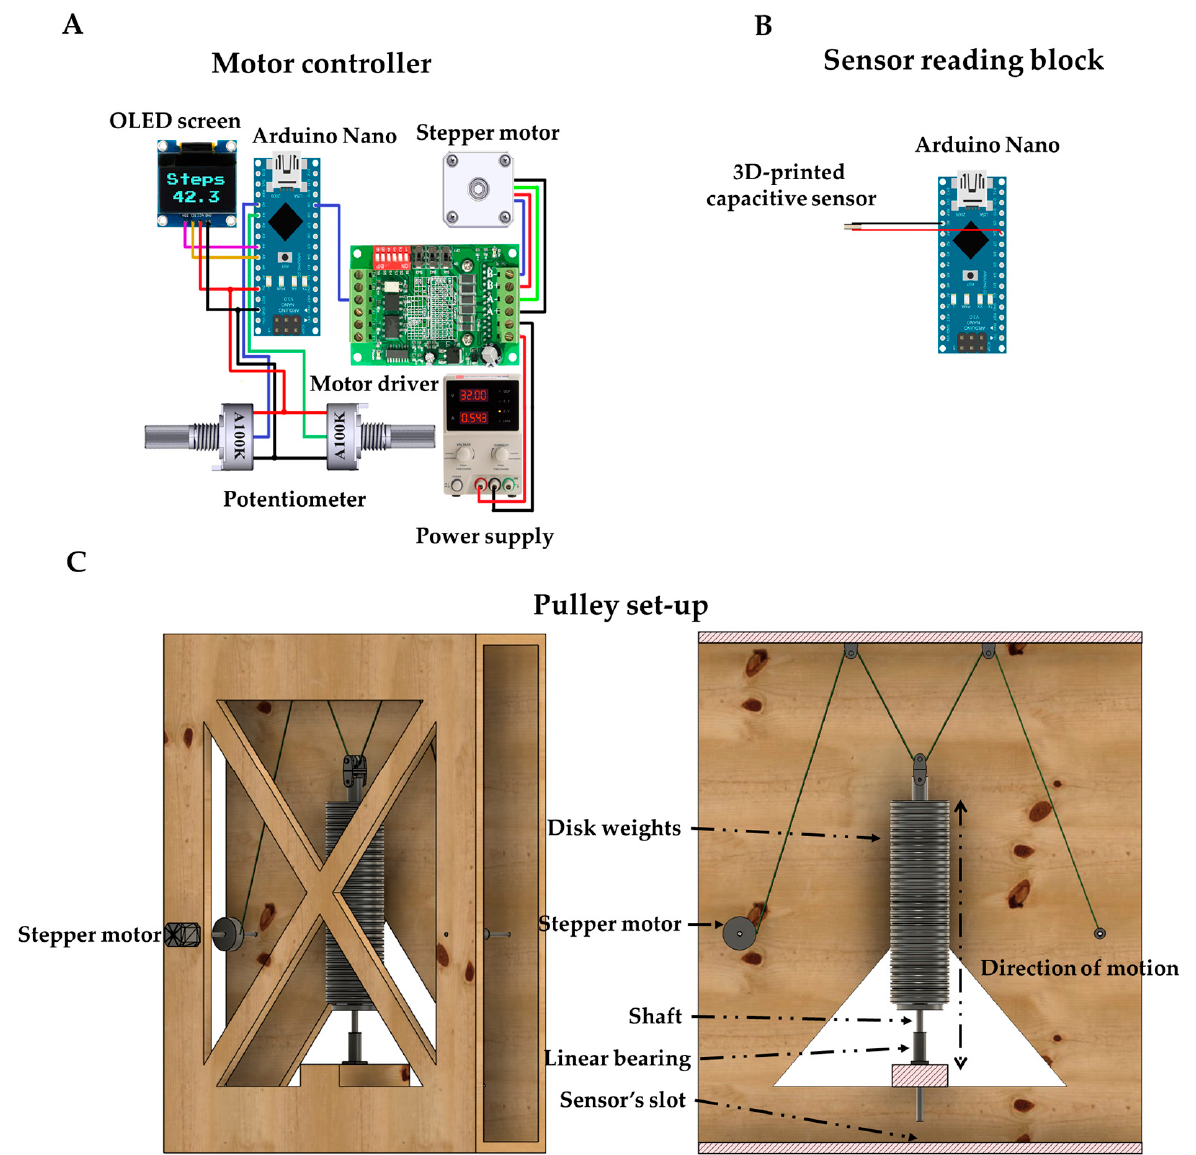
Figure 2. Experimental set-up for dynamic measurements; ( A ) motor control circuit, ( B ) capacitive sensor reading block and ( c ) pulley set-up system.